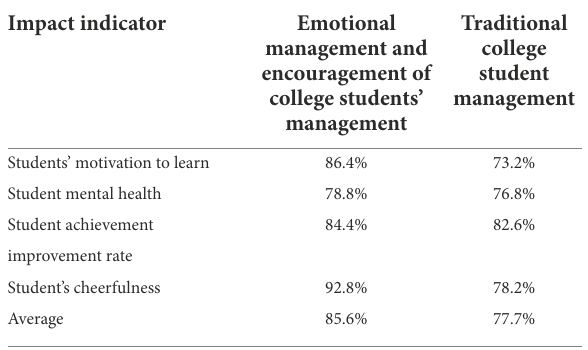
TABLE 3 Effectiveness analysis result